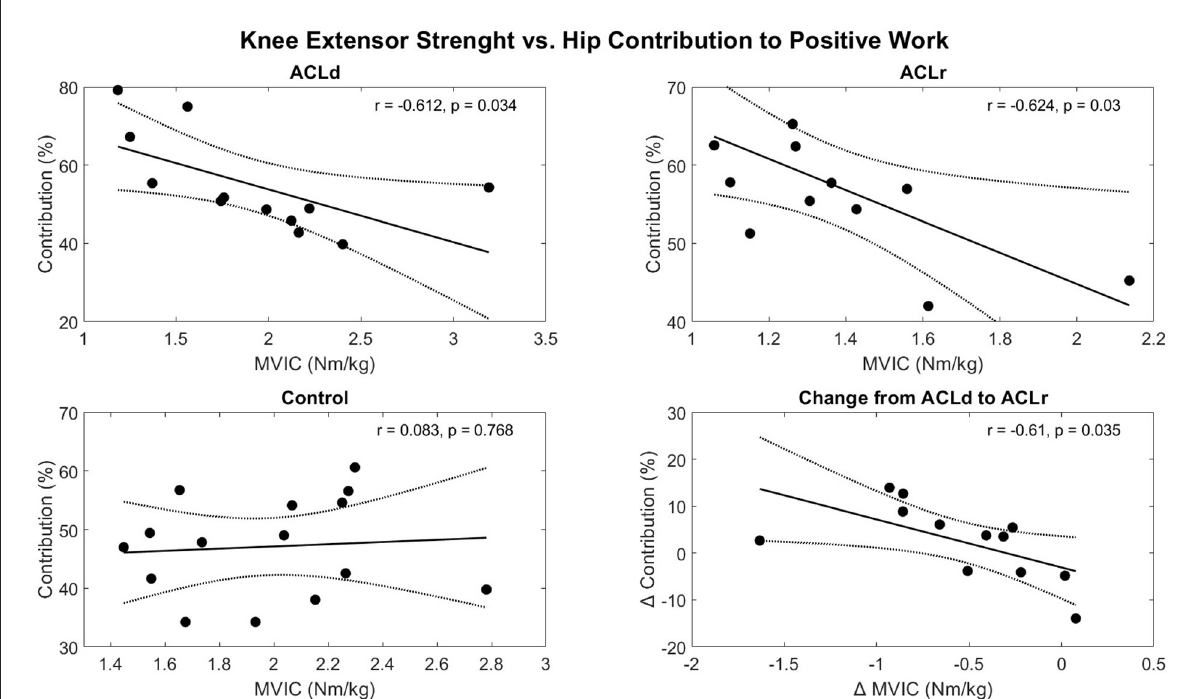
FIGURE6 Correlations between the knee extensor strength and hip contribution to positive work performed during the forward lunge. A significant negative correlation was observed between knee extensor strength and hip contribution to the positive work both before and after ACL reconstruction. In addition, the change in knee extensor strength and the change in hip contribution were correlated in the patients with an ACL injury. The solid line represents the best fit line and the dotted lines the 95% confidence bounds of the